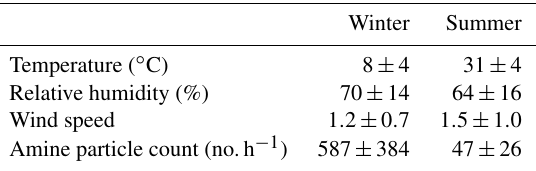
Table 1. Meteorological factors and particle counts in summer and